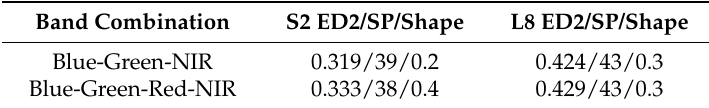
Table 2. Modified ED2 and its associated scale and shape parameters (compactness was fixed to 0.5) for the tested Sentinel-2 (S2) and Landsat 8 (L8) equal-weighted band combinations. In grey, the best results achieved.